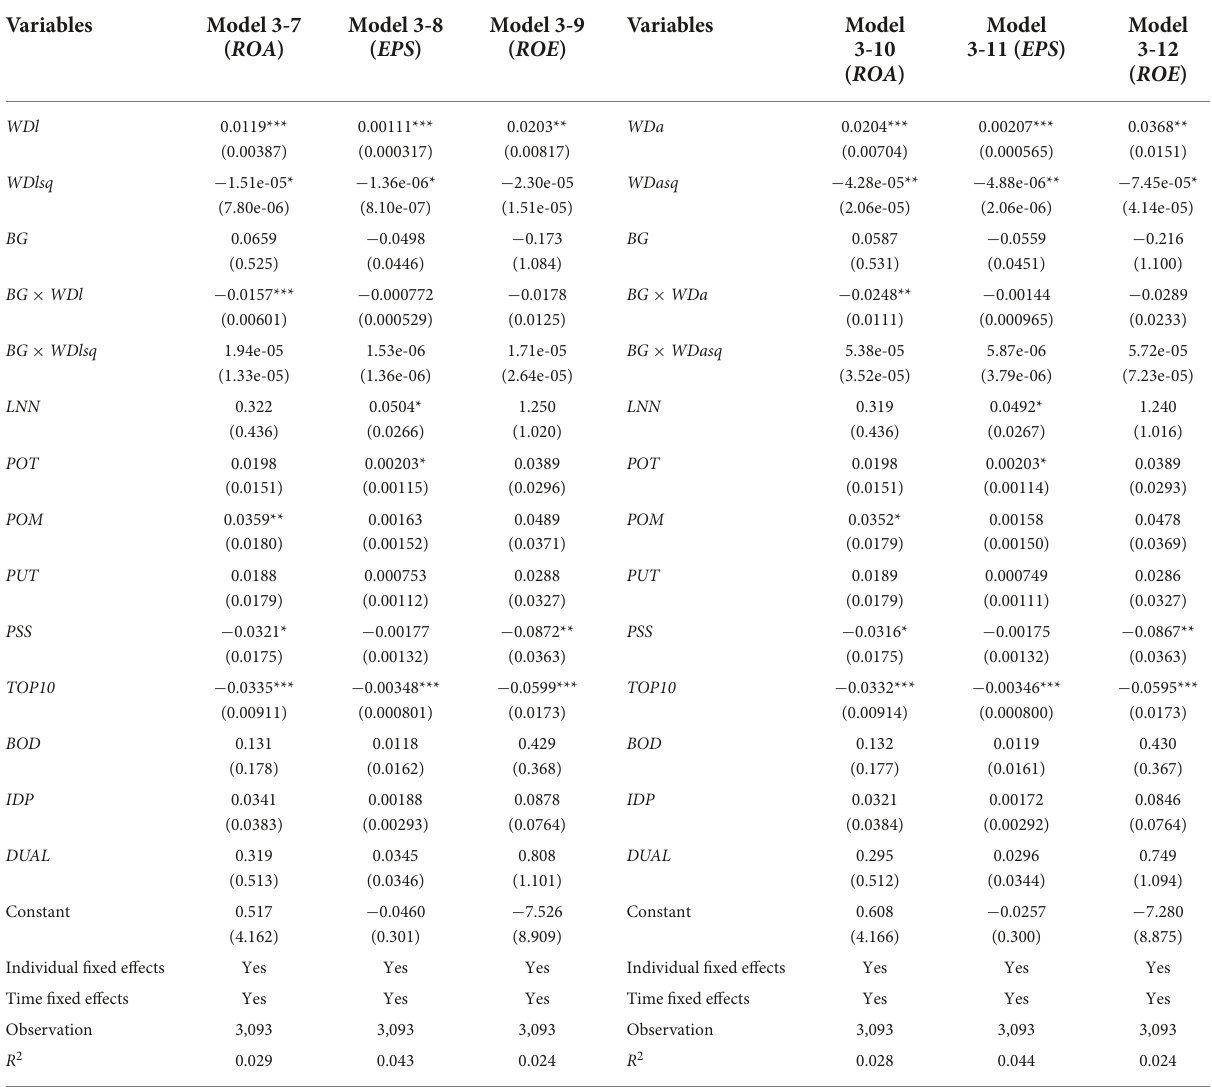
TABLE 7 Robust test Model 3 with replacement of moderating